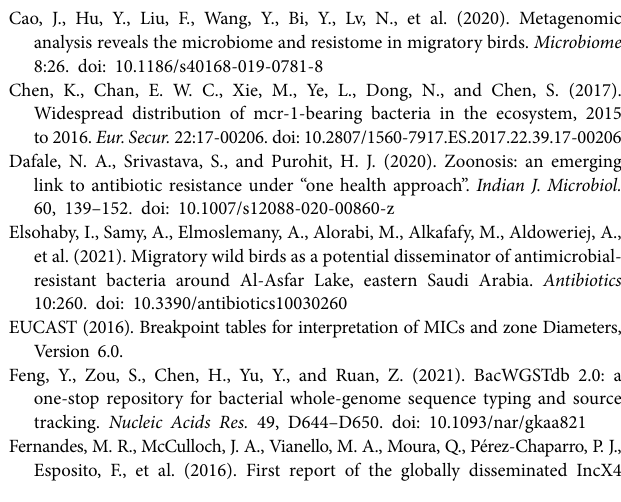
Supplementary Figure S1 | Single polynucleotide pair (SNP)-heatmap analysis of MCRPE isolates used in this study using SNP count matrices. Supplementary Figure S2 | The antimicrobial sensitivity of 22 MCRPE for 15 antibiotics, yellow indicates that the strain is not sensitive to the drug (CS, colistin; FOS, Fosfomycin; STR, streptomycin; OLA, olaquindox; NAL, nalidixic acid; GEN, gentamicin; AMK, amikacin; FOX, cefoxitin; CTX, cefotaxime; FFC, florfenicol; CIP, ciprofloxacin; TET, tetracycline; MEM, meropenemS/T; TIG, tigecycline;